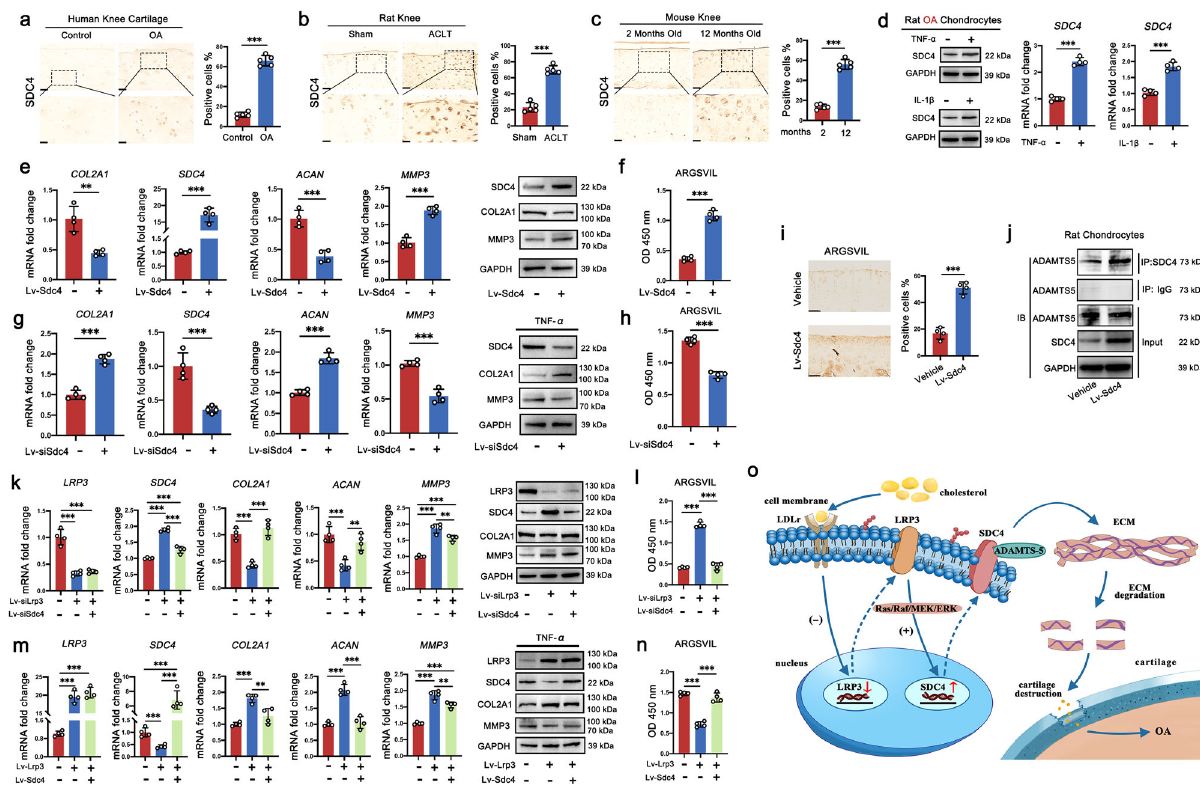
Fig. 7 | Identi fi cation of SDC4 as the downstream molecular target of LRP3 in chondrocytes.a IHCstainingforSDC4inhumancartilage( n =5). b IHCstainingfor SDC4in rat tibial cartilage ( n =5). c IHCstaining for SDC4 inmouse tibialcartilage, ( n =5). d Quanti fi cation of SDC4 mRNA ( n =4, two-tailed Student ’ s t -test) and proteins levels ( n =3) in rat chondrocytes treated with IL-1 β (10ng/ml) and TNF- α (20ng/ml). e Quanti fi cation of mRNA ( n =4) and proteins levels ( n =3) in rat chondrocytes treated with Lv-Sdc4. f The Elisa analysis of ARGSVIL in the cell culture supernatantof ratchondrocytestreated withLv-con335orLv-Sdc4( n =4). g Quanti fi cation of mRNA ( n =4) and proteins levels ( n =3) in TNF- α (20ng/ml)- induced rat OA chondrocytes treated with Lv-siSdc4. h The Elisa analysis of ARGSVIL in the cell culture supernatant of TNF- α (20ng/ml)-induced rat OA chondrocytes treated with Lv-siSdc4 ( n =4). i IHC staining for ARGSVIL in tibial cartilage of vehicle or Lv-Sdc4 injected rats ( n =4). j The interaction of SDC4